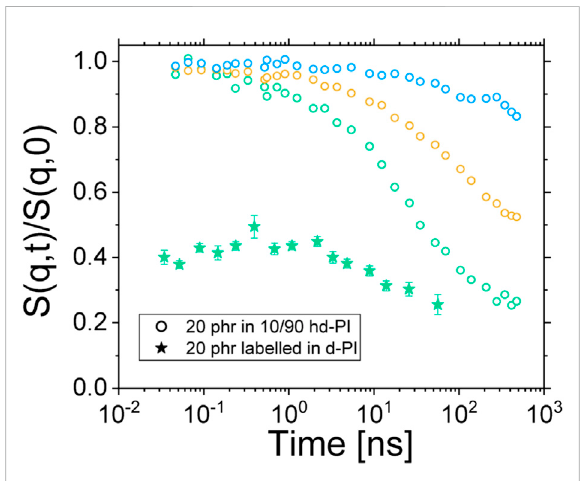
FIGURE 10 Hydrodynamic reinforcement as a function of fi ller volume fraction. Blue circles are for the time shifting parameter t scale measured by NSE at 413 K. Lines are for phenomenological approaches described by Eqs 6 – 10 of Section 3.3.